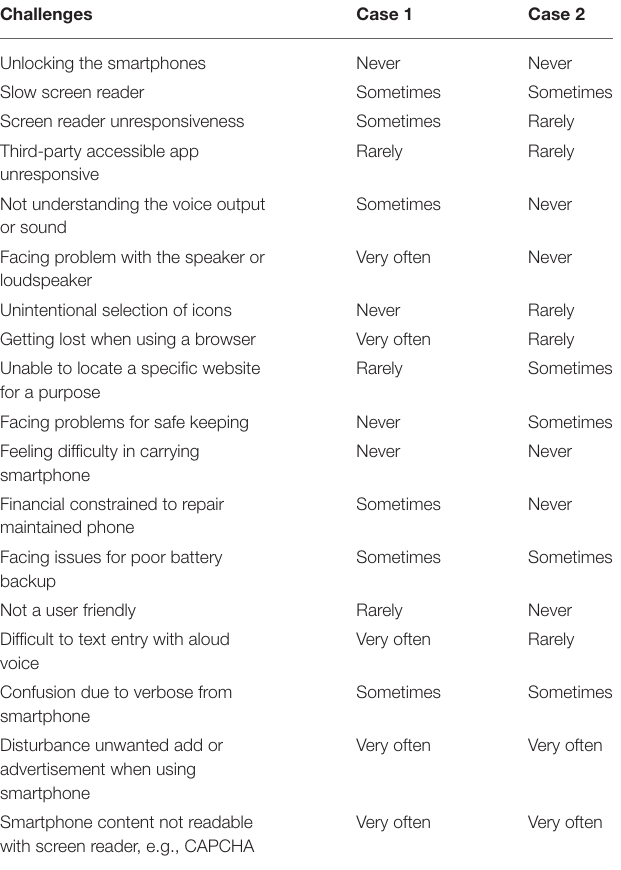
TABLE 3 | Challenges faced during the smartphone